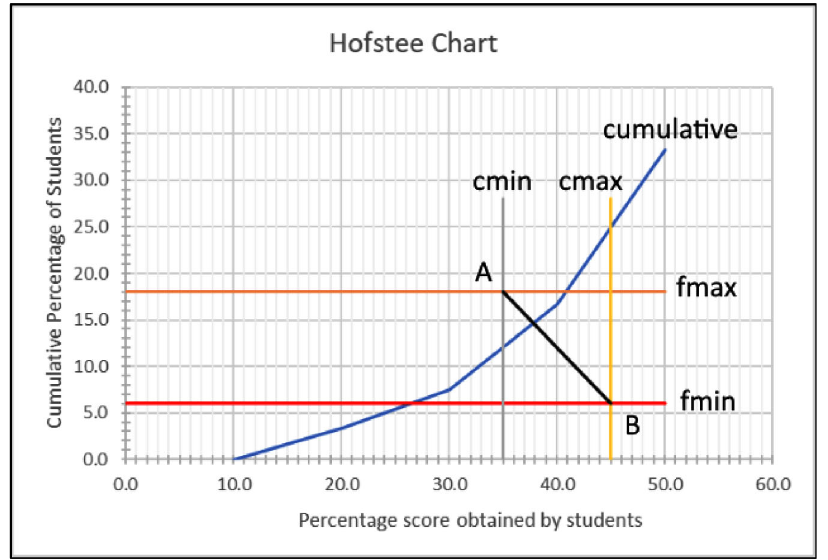
Figure 1. Hofstee chart showing cumulative scores, where c min (minimum cut-off score) = 35, c max (maximum cut-off score) = 45, f min (the lowest percentage of students that the judges feel should fail) = 6, and f max (the highest percentage of students that the judges feel should fail) =